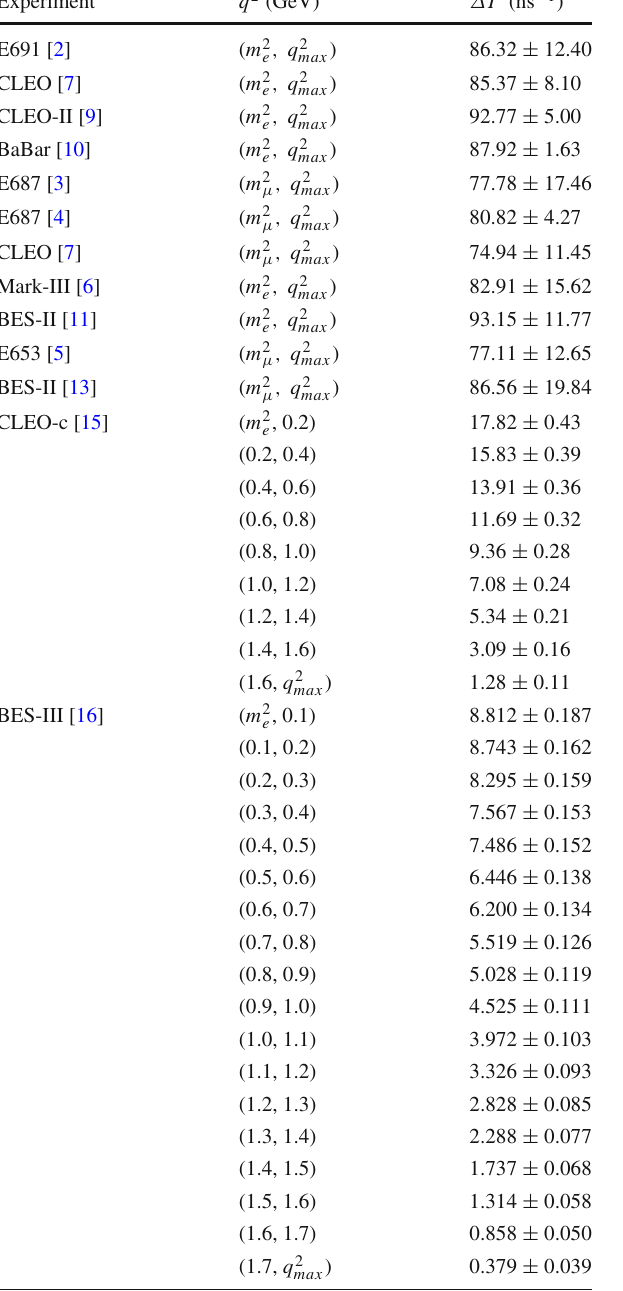
Table4 Partialdecayrates ΔΓ of D + → ¯ K − (cid:2) + ν (cid:2) decaysin q 2 ranges Experiment